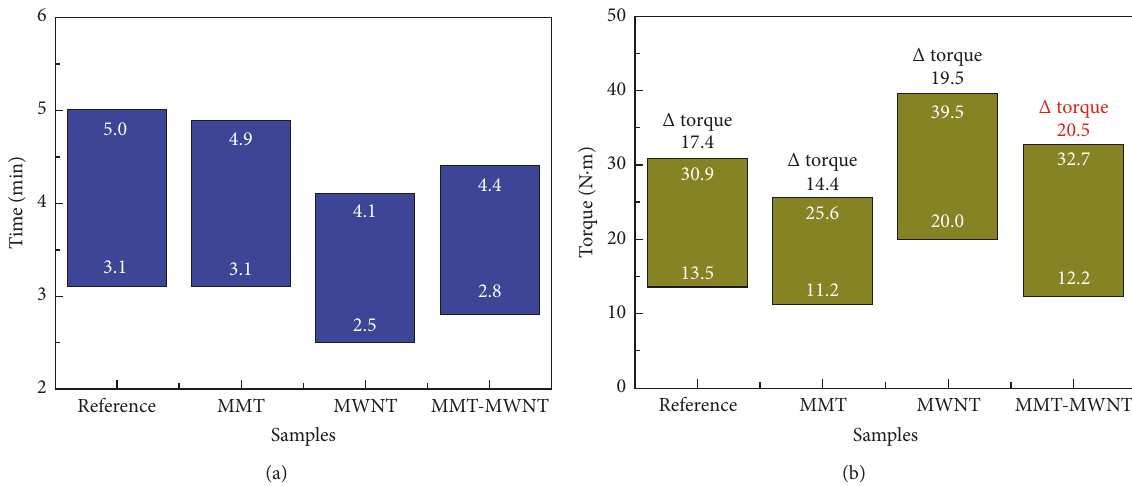
Figure 2: (a) Curing properties of elastomer nanocomposites with diverse fillers. (b) Torque of elastomer nanocomposites. (c) Stress-strain curves of the elastomer nanocomposites with diverse fillers. (d) Elastic modulus and toughness of the elastomer nanocomposites with diverse fillers.